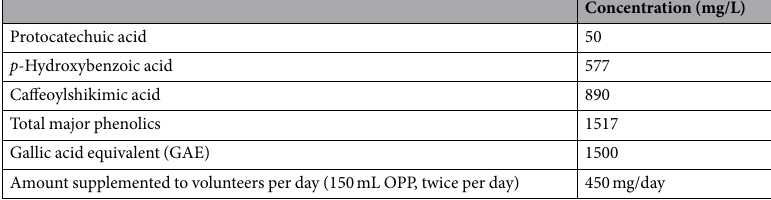
Table 2. Mean concentrations of major phenolic compounds in oil palm phenolics (OPP).